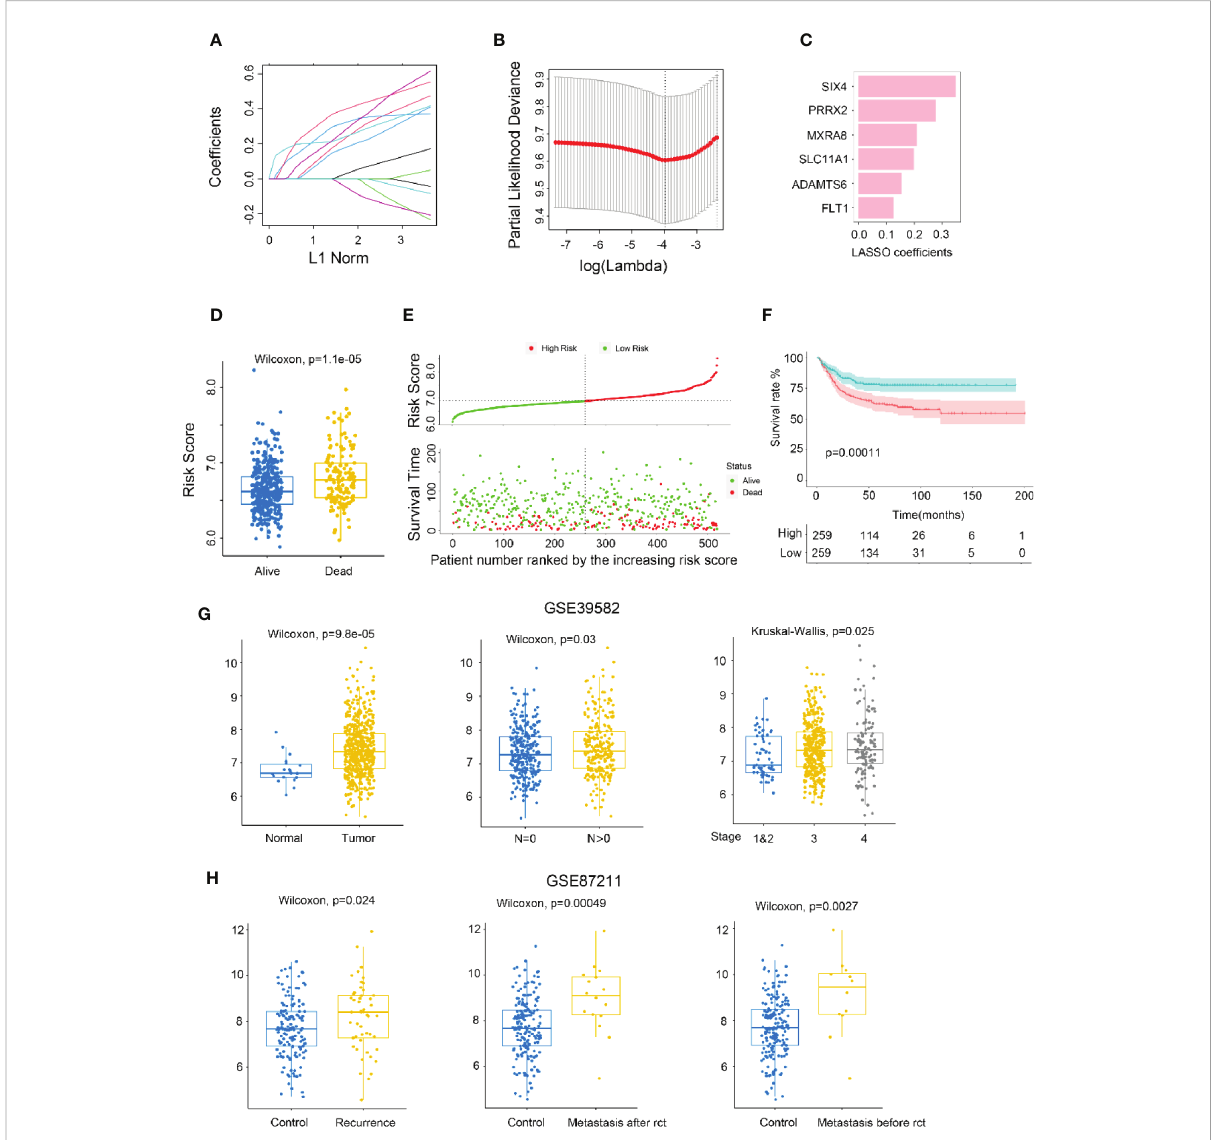
FIGURE 2 Identifying MXRA8 as a hub gene. (A) LASSO coef fi cient pro fi les of metastasis-related prognostic differential expressed genes. (B) 10-fold cross- validation for penalty parameter l selection in LASSO model. (C) LASSO coef fi cients of six metastasis-related genes. (D) Comparison of risk scores in alive and dead patients. (E) The distribution of risk score, patients ’ status, and RFS time. (F) Kaplan – Meier RFS curves for patients in high- and low-risk groups. (G) Boxplot indicating MXRA8 expression in normal/tumor (left), lymph metastasis or not (middle), and different stages (right) from GSE39582 database. (H) Boxplot indicating MXR8 expression in normal/recurrence (left), normal/metastasis after resection (middle), normal/metastasis before resection (right) from TCGA